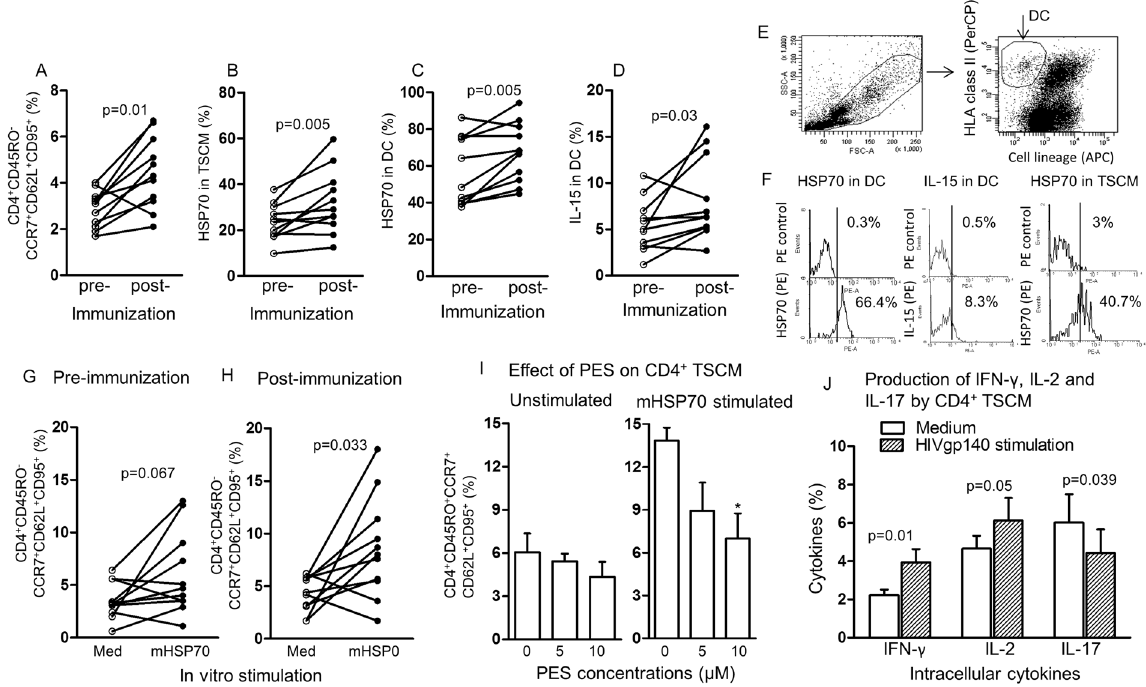
Figure 4. The effect of vaccination on inducible HSP70 in CD4 + TSCM and DC before and 28 weeks after immunization. ( A ) CD4 + TSCM, ( B ) HSP70 in CD4 + TSCM, ( C ) HSP70 in DC, ( D ) membrane associated (ma)IL-15 in DC. ( A–D ) Assays were performed on cells from the same vaccinees (n = 11). ( E ) Gating strategy used to identify DC. ( F ) Flow cytometry identifying HSP70 and IL-15 in DC, and HSP70 in TSCM. ( G ) The effect of stimulating CD4 + TSCM with microbial (m) HSP70 before and ( H ) after immunization. ( I ) The effect of dose dependent inhibition of HSP70 with PES in unstimulated and microbial (m)HSP70 stimulated CD4 + TSCM; * p value = 0.02, when compared with the untreated (0) µ M of cells. ( J ) The effect of stimulating CD4 + TSCM with HIVgp140, compared with unstimulated cells on IFN- γ , IL-2 and IL-17 (n = 10 samples from different